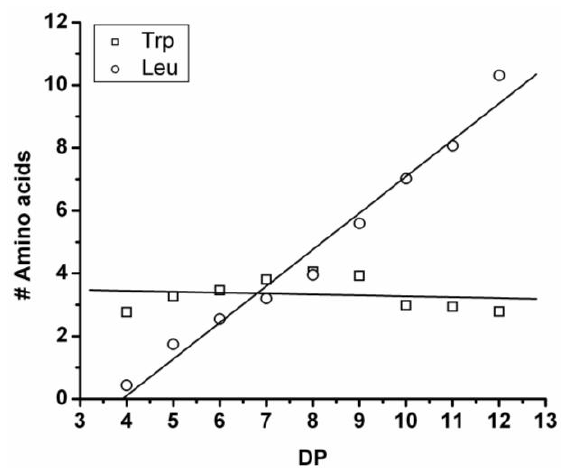
Figure 15. Average number of amino acids in poly(Trp-co-Leu) for every observed